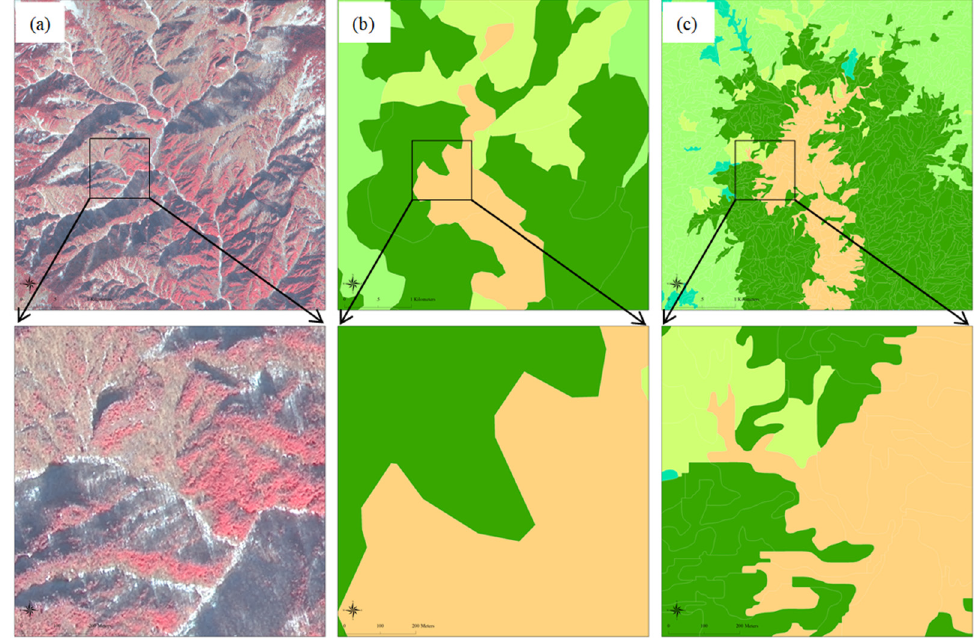
Figure 11. Details of the comparison in Subarea B of Figure 9. ( a ) the GF-2 image with a 4/3/2 band combination; ( b ) 1:50,000 vegetation map; c: our mapping result.